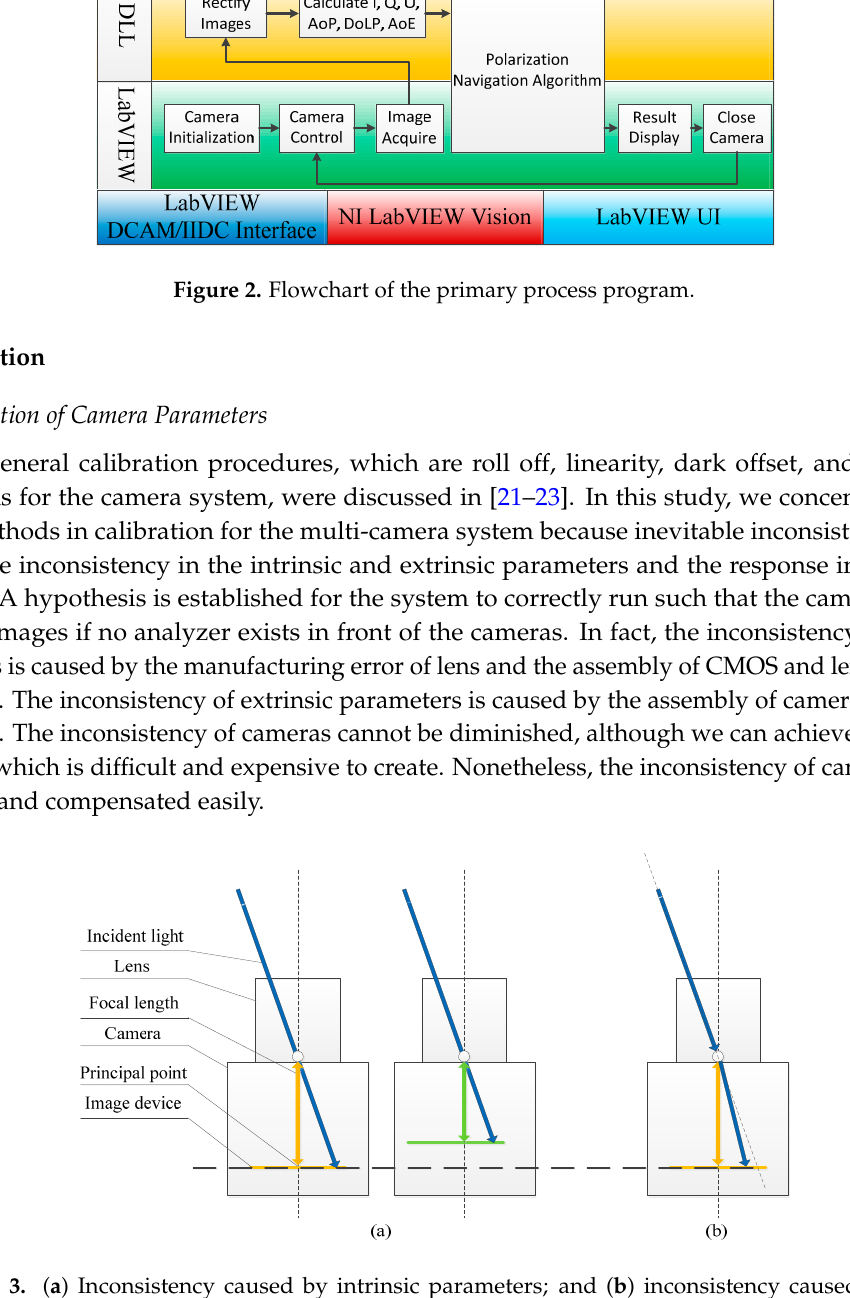
Figure 3. ( a ) Inconsistency caused by intrinsic parameters; and ( b ) inconsistency caused by the distortion of lens.